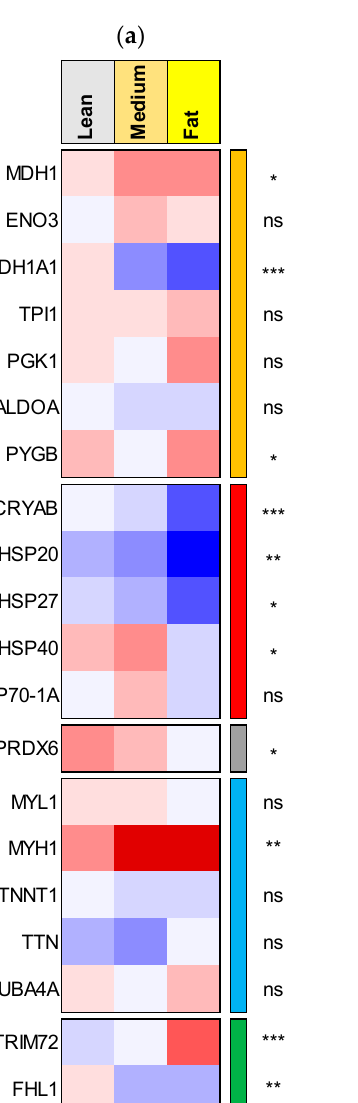
7.72 ± 1.58% (CV, 20%), Min = 6.34 and Max = 13.82%. Medium class: 4.72 ± 0.63% (CV, 13%), Min = 3.76 and Max = 6.11%. Lean class: 2.72 ± 0.62% (CV, 23%), Min = 0.45 and Max = 3.69%.